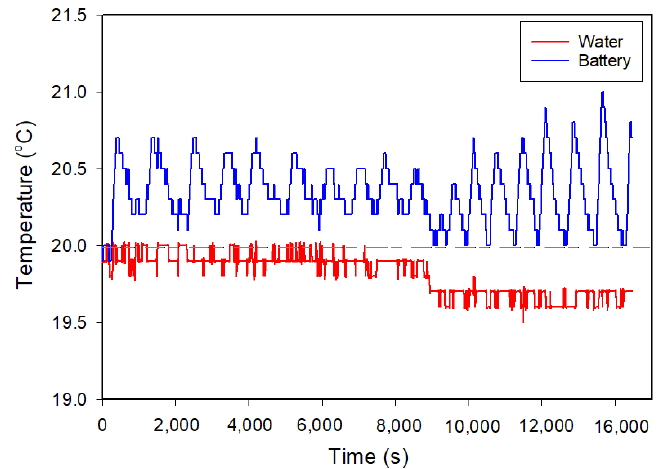
Figure 4. The experimental results of battery temperature and cold water temperature under the controlled condition of 20 °C during the discharging process .